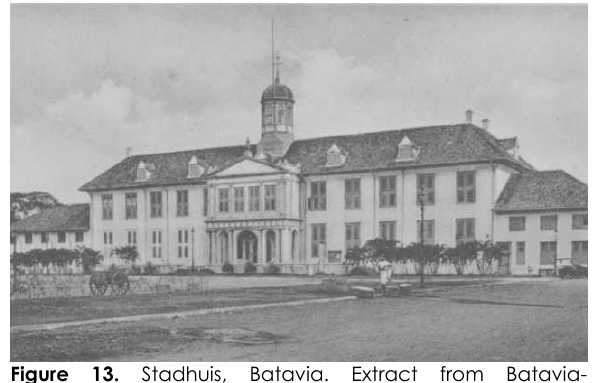
Figure 13. Stadhuis, Batavia. Extract from Batavia- Weltevreden-Meester Cornelis, Centrale Bibliotheek, Amsterdam.